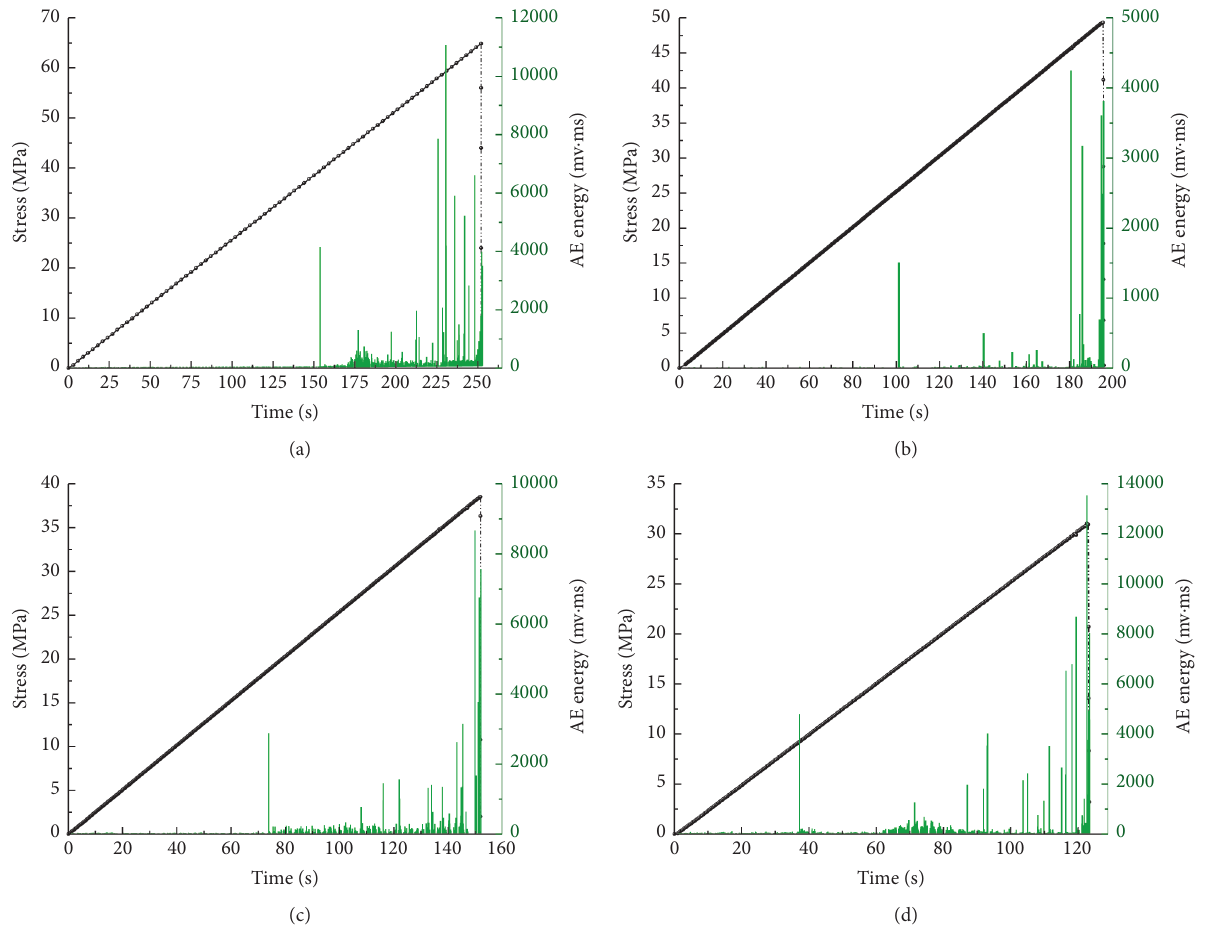
Figure 7: The AE energy evolution during the entire loading process of intact (a) and precracked rock specimens with a dip angle of 30 ° (b), 45 ° (c), and 60 °